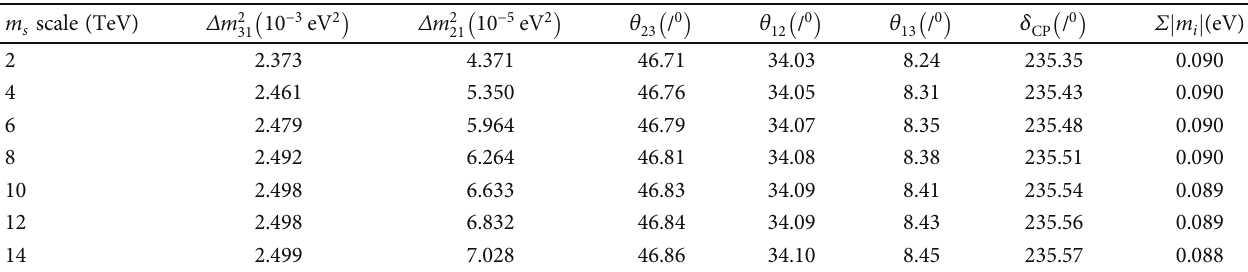
for NH case ð tan β = 40, M s